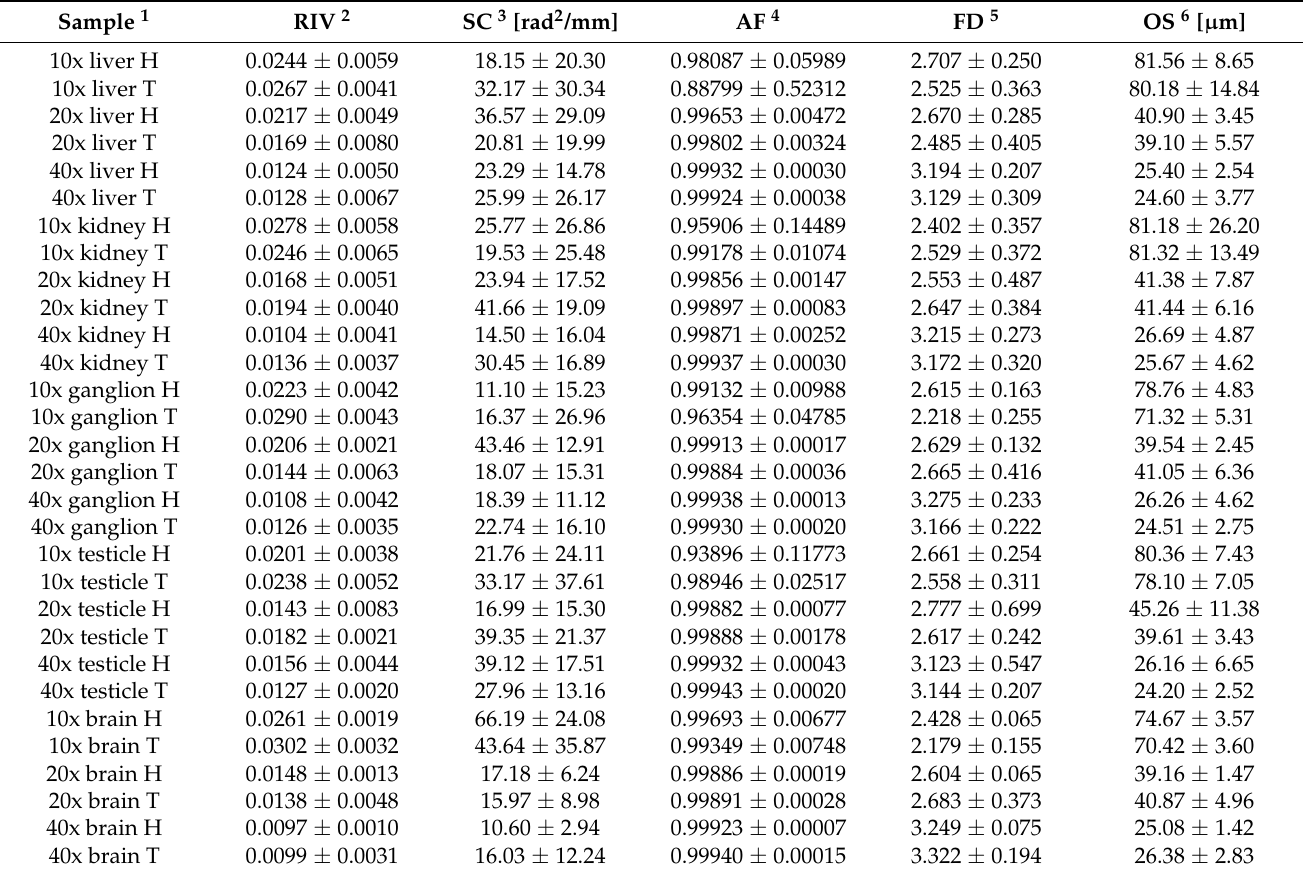
tissue type, state and magnification